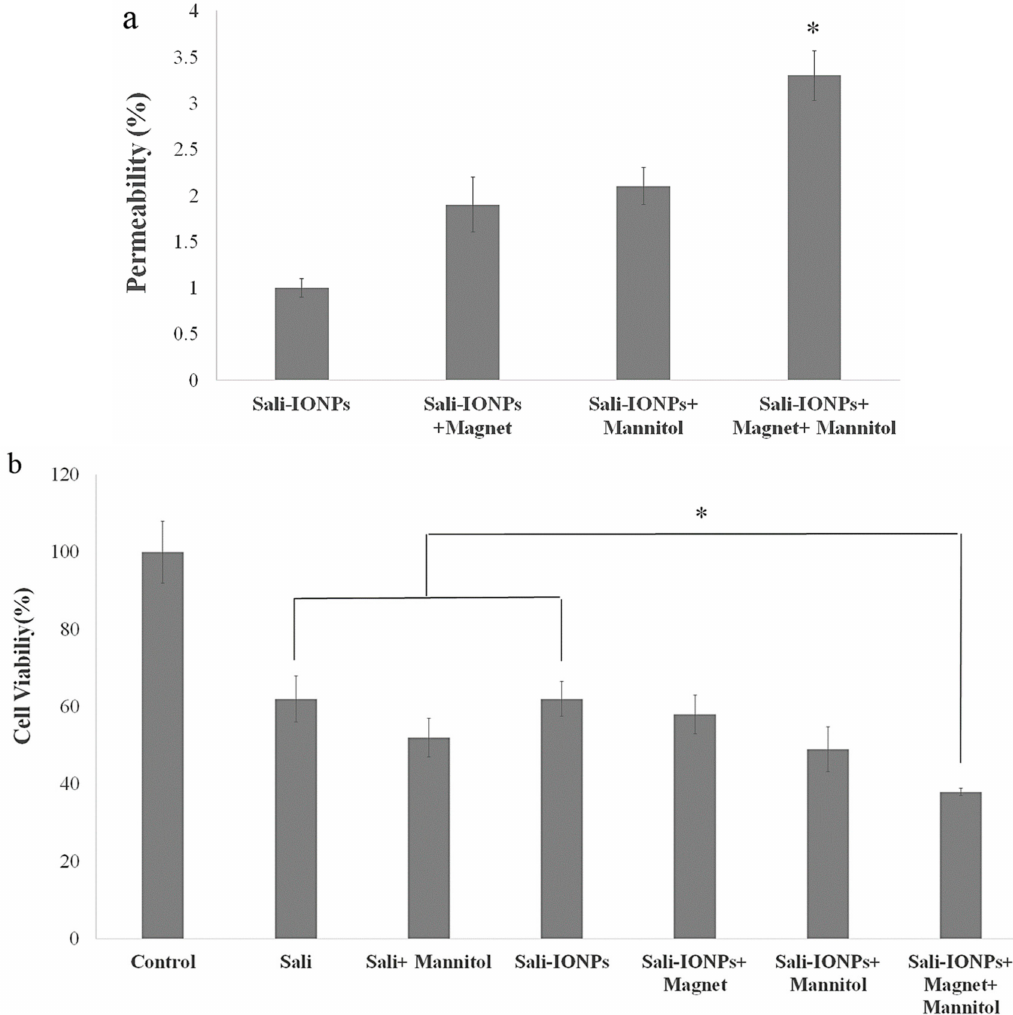
Figure 11. Evaluation of anticancer e ffi cacy of Sali-IONPs compared to the free salinomycin on a BBB-brain tumor model in vitro : ( a ) Sali-IONPs permeability across the bEnd.3 monolayer with or without magnet and mannitol; ( b ) cytotoxicity of each formulation on U251 cells after penetrating the bEnd.3 monolayer. Note: * indicates a significant di ff erence at p < 0.05 with the other treated groups. Data was presented as mean ± SD; n =